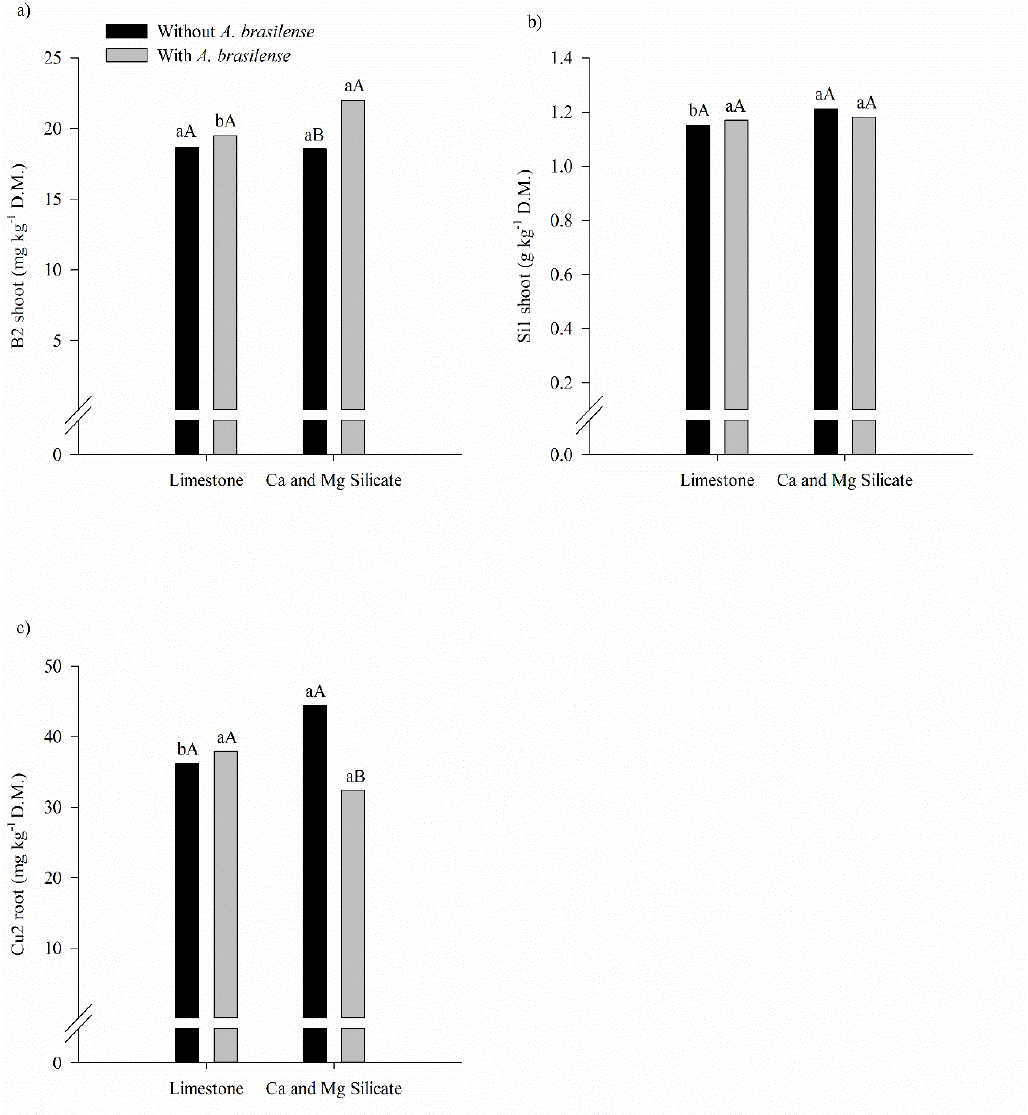
Figure 5. Interaction between sources of acidity correctives and inoculation with Azospirillum brasilense in B (a) and Si (b) concentration in shoot and Cu (c) in root. Selvíria, MS – Brazil, agricultural crop 2015/2016 1 and 2016/2017 2 . Means followed by the same letters tiny for sources of acidity correctives and uppercase for inoculation with Azospirillum brasilense do not differ by Tukey at 0.05 probability